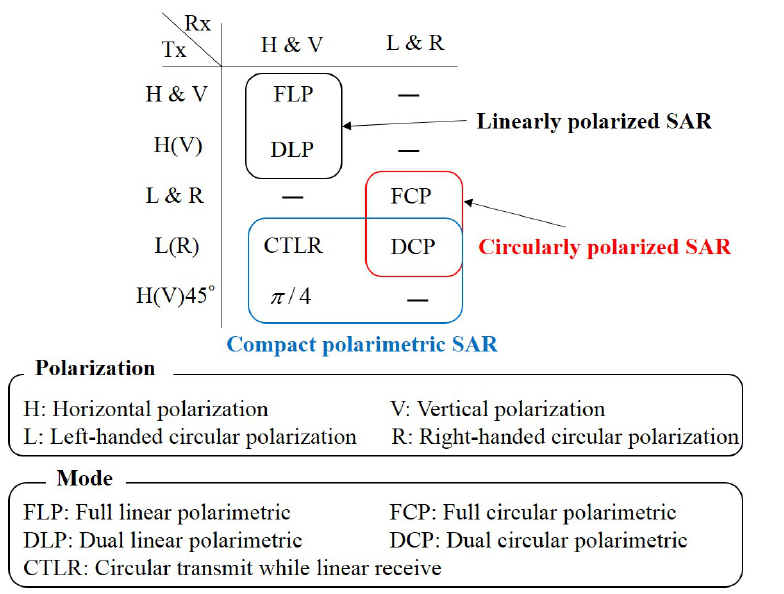
Figure 1. Categorization of various polarimetric synthetic aperture radar (SAR)